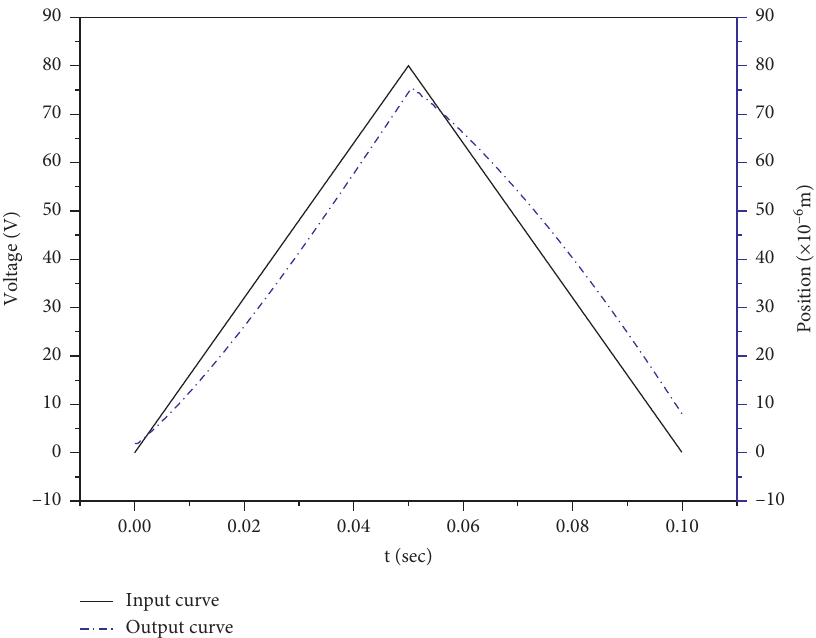
Figure 6: Triangle input voltage curve and output displacement curve.